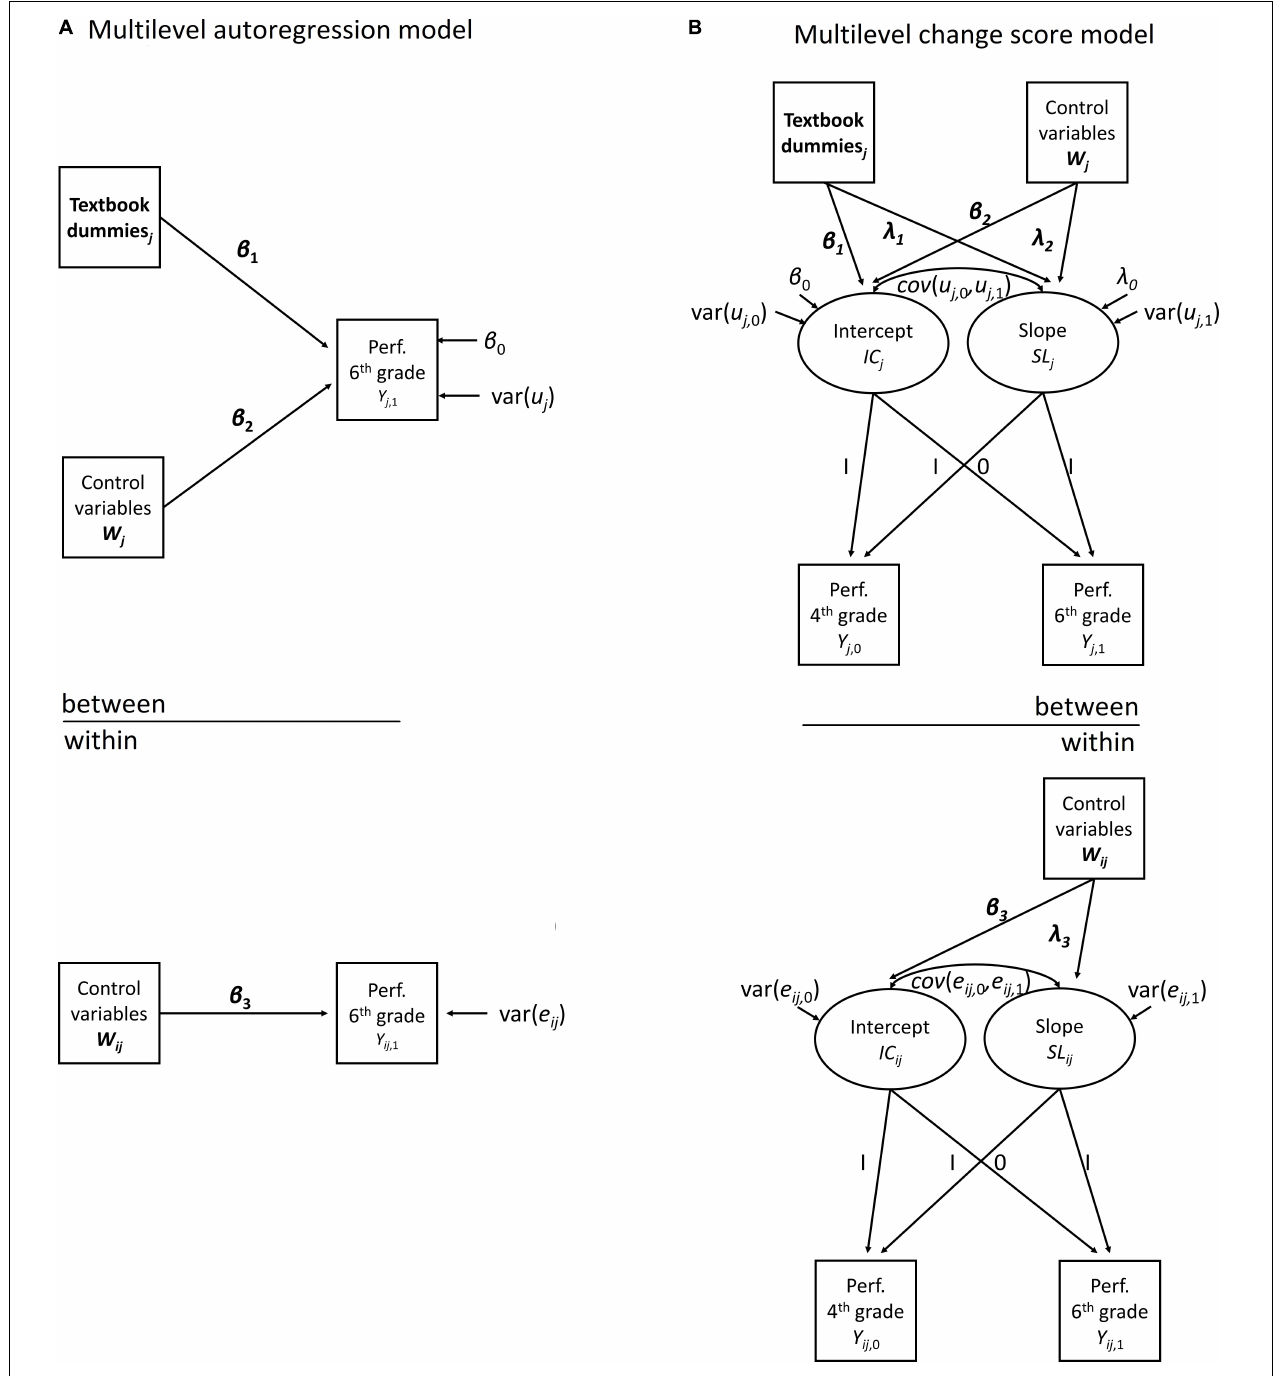
FIGURE 1 | Comparison of multilevel autoregression model and multilevel change score model for assessing the effects of textbooks on learning progress in reading comprehension between fourth and sixth grade.